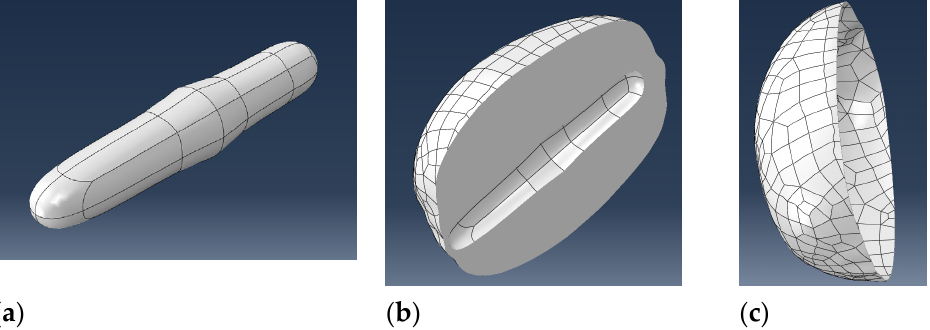
Figure 3. Organization of each part of the kiwifruit three-dimensional model. ( a ) Placenta; ( b ) Flesh; ( c ) Peel.